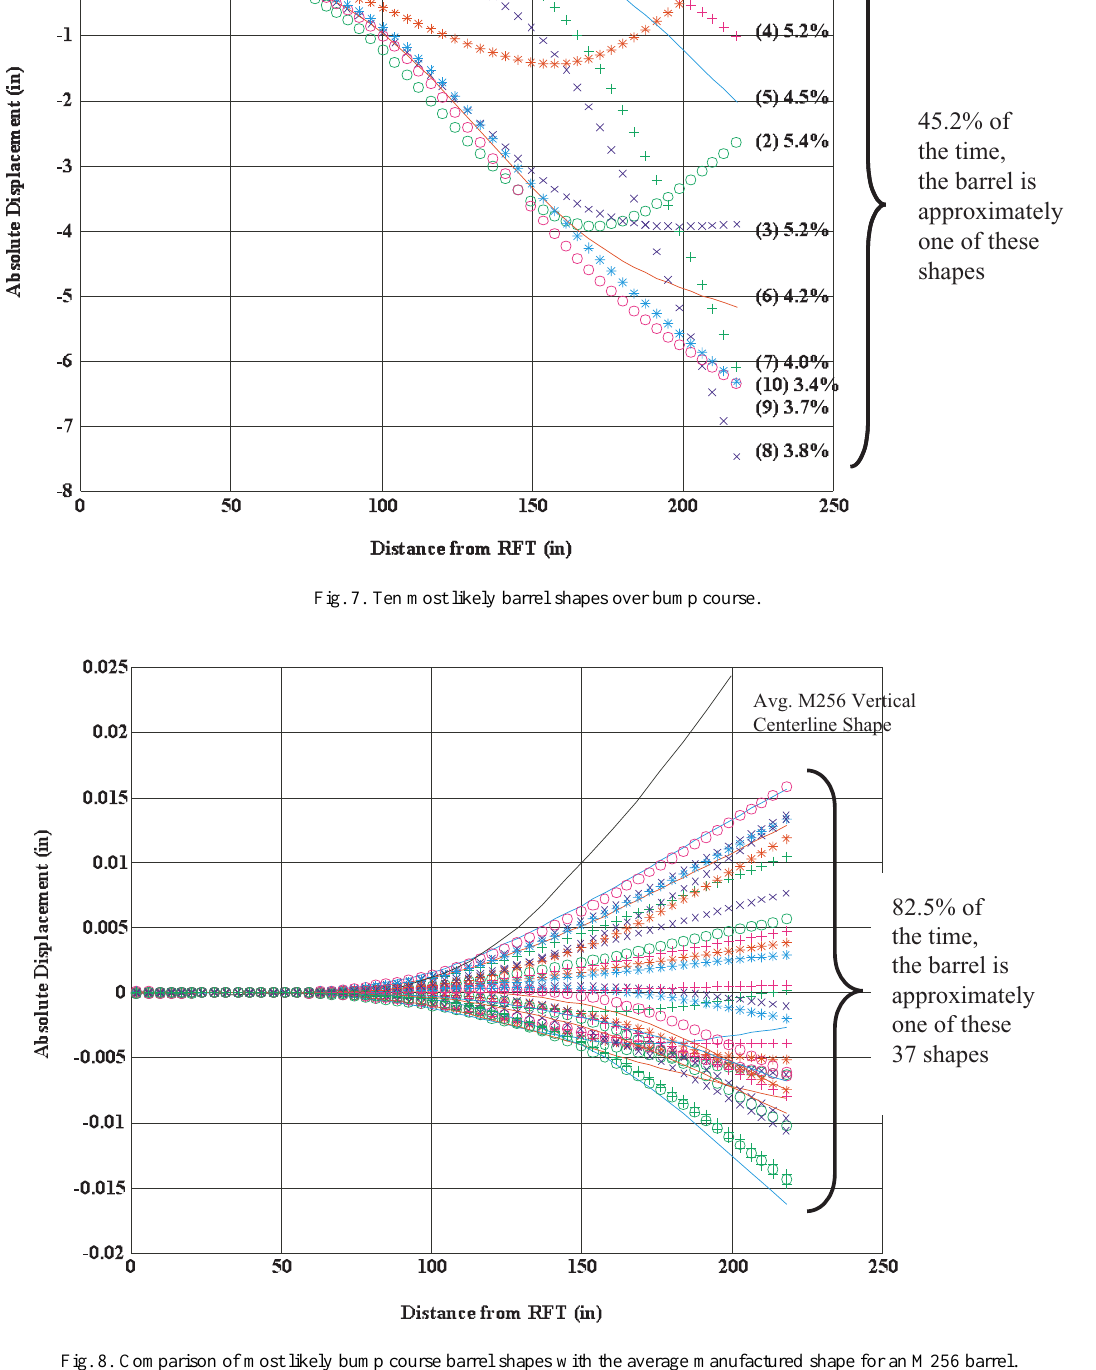
Fig. 8. Comparison of most likely bump course barrel shapes with the average manufactured shape for an M256